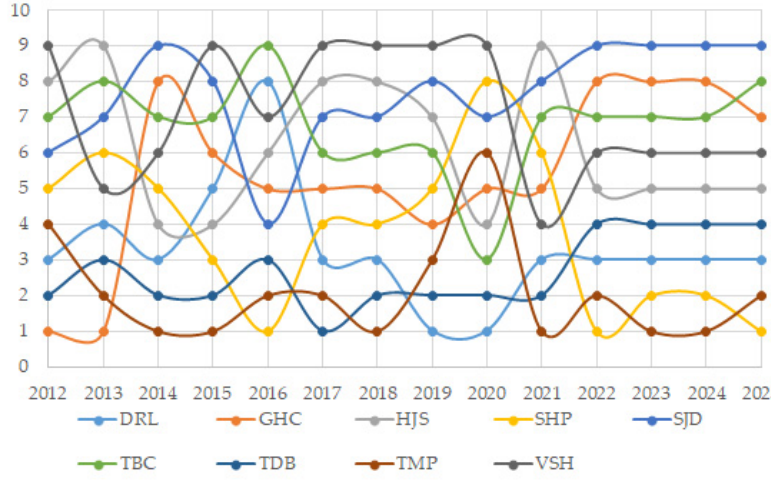
Figure 2. Position of hydropower suppliers from past to future. Figure 2 reveals that the positions of each hydropower supplier change continually. With a long period of 14 years, including ten previous years and four future years, none of the suppliers holds the first rank in the whole term; moreover, HJS, SJD, TBC, and VSH do not approach the first position at any time. HJS, SJD, and VSH range from the fourth to ninth positions. HJS ranked from the fourth to ninth position in the historical time and is expected to hold the fifth position in the next four future years. SJD and VSH had one year at the fourth position; however, VSH is expected to hold the sixth position in future terms; on the contrary, SJD will be down the final position in future terms. TBC only stayed at the third position in 2020 and ranks from sixth to ninth position in the remaining years. TMP is the best supplier and achieves the first rank within six terms in the whole term; other terms rank from the second to sixth position. SHP ranges in the first rank within three terms; its position was down to the eighth position in 2022. GHC achieved the first position within two terms in 2012 and 2013; its position from 2022 to 2025 will rank the low position. DRL attained the first rank in two continual terms from 2019 to 2020; however, it was down the eighth position in 2016. TDB only approached the first rank in 2018; the remaining terms are from the second to fourth position. As a result, the position of hydropower suppliers every year changes when their classes are determined based on the individual scores.